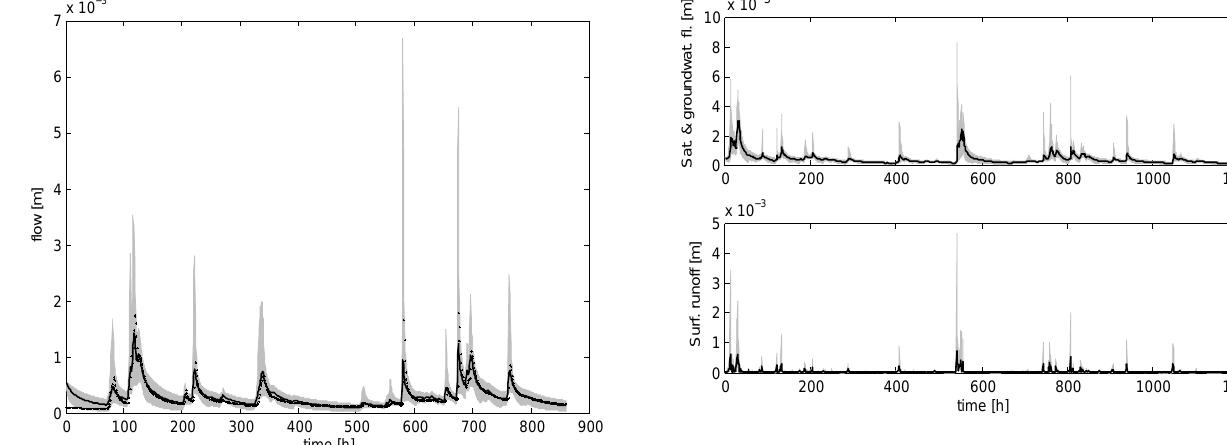
Fig. 5. Uncertainty estimation of the discharge from the satu- rated subsurface store (upper panel) and of the “surface runoff” (lower panel) of the TOPMODEL; simulations (posterior mean) are marked by a solid black line, shaded area denotes 95% confidence